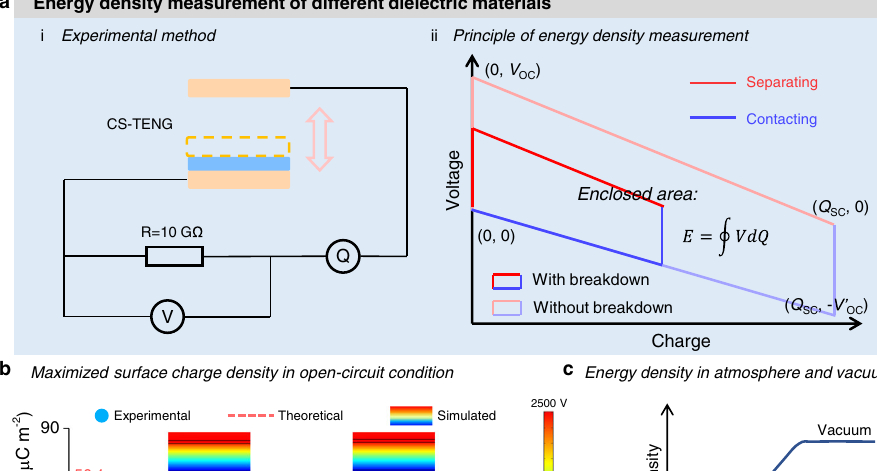
Fig. 5 | Energy density measurement of dielectric materials based on TECD in vacuum. a Energy density measurement method and principle. i Experimental method; ii principle. b Theoretical, simulated and experimental results of max- imumsurfacechargedensityinopen-circuitcondition. c Schematicdiagramshows